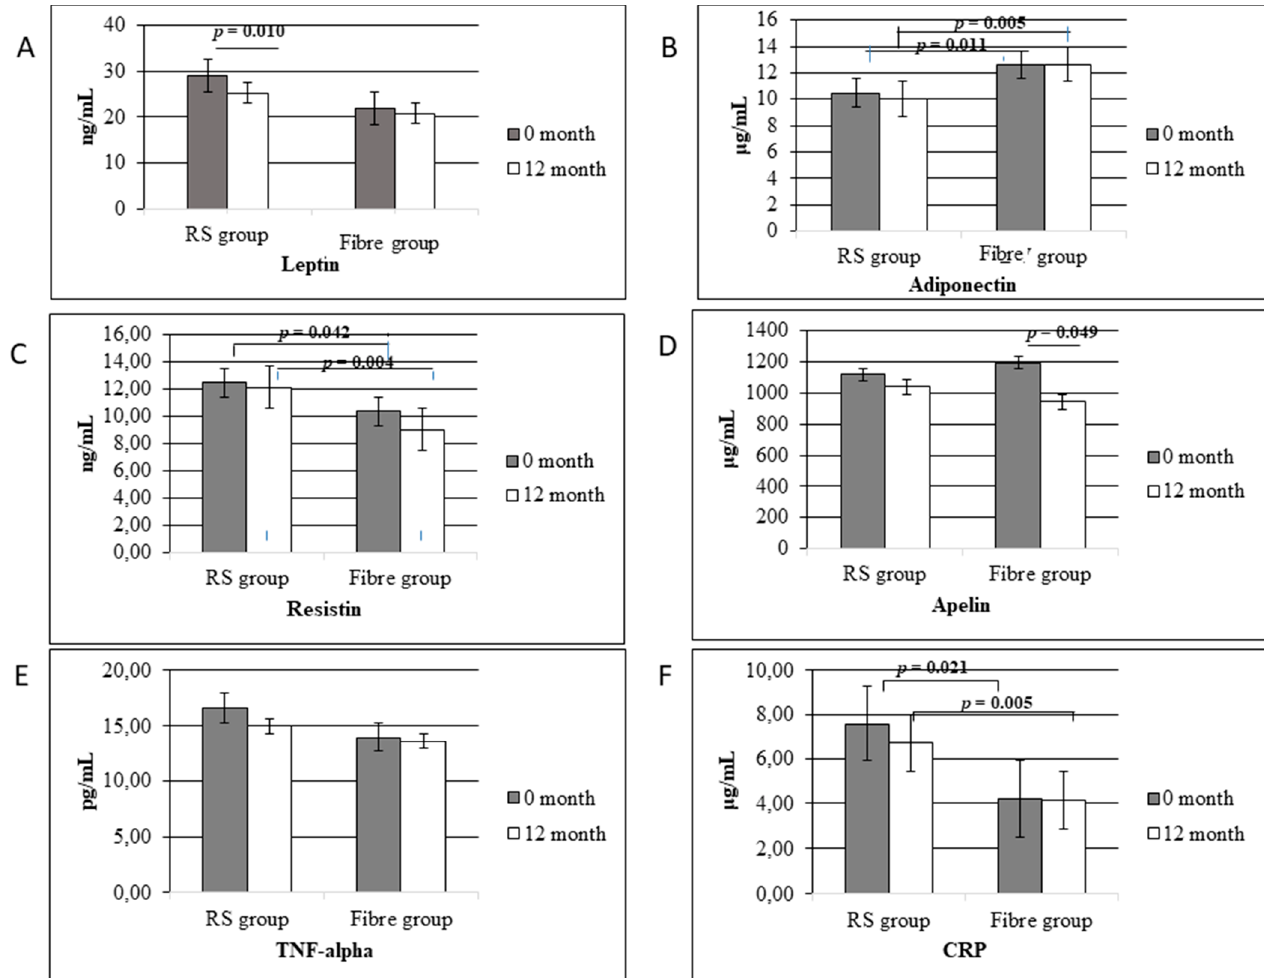
Figure 5. Plasma levels of adipokines: ( A ): leptin, ( B ): adiponectin, ( C ): resistin, ( D ): apelin) and factors of inflammation: (( E ): TNF-alpha, ( F )): CRP in the subject groups at the beginning and after dietary and lifestyle intervention.